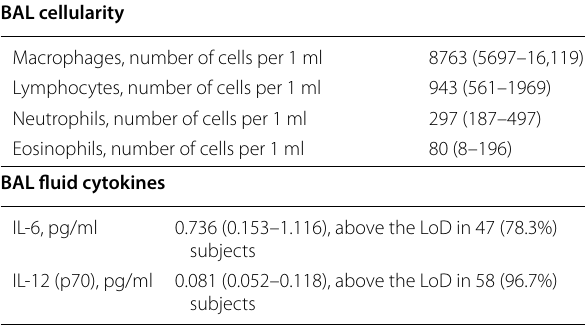
Table 3 Results of BAL investigations in asthmatics